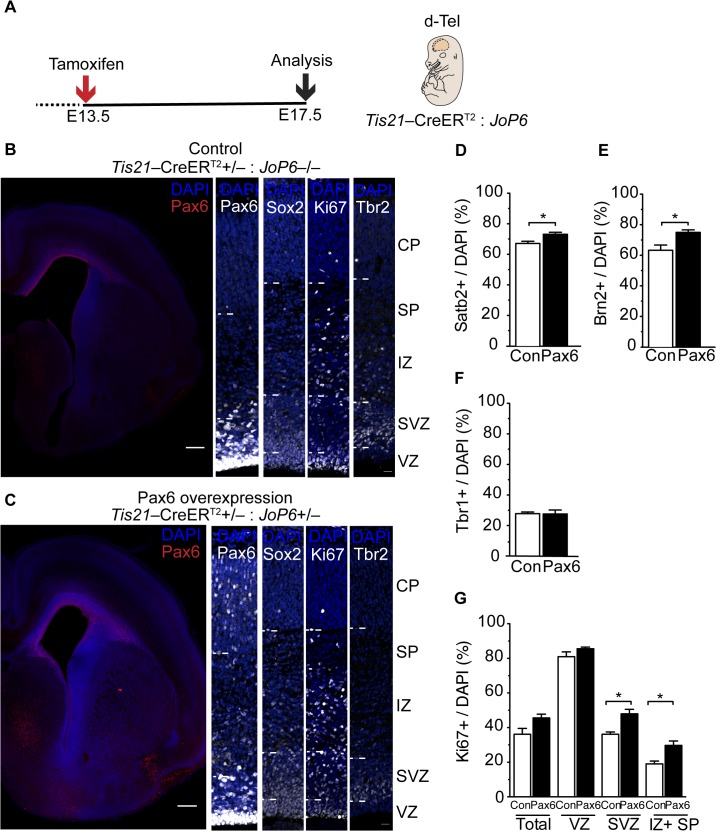
Double-transgenic mouse embryos sustaining Pax6 expression show increased BP abundance and upper-layer neuron production.(A) Flow scheme of experiment. (B–G) Dorsolateral telencephalon of tamoxifen-treated E17.5 Tis21–CreERT2: JoP6 double-transgenic mice; control (Tis21–CreERT2+/–: JoP6–/–) (B) and Pax6 overexpression (Tis21–CreERT2+/–: JoP6+/–) (C) littermates. (B,C) Representative images showing Pax6 (red and white), Sox2 (white), Ki67 (white), or Tbr2 (white) immunofluorescence, combined with DAPI staining (blue), on coronal 50-μm vibratome sections. Scale bars, 20 μm. Note the lack of heterotopia formation in the Pax6 overexpression condition in the Pax6 overview image in (C). (D–F) Quantification of Satb2+ (D), Brn2+ (E) and Tbr1+ (F) nuclei in the cortical plate (100-μm wide area), in control (Con, white) and Pax6 overexpression (black) littermates. (G) Quantification of Ki67+ nuclei in the cortical wall except for the cortical plate (total), VZ, SVZ, and intermediate zone plus subplate (IZ + SP) (100-μm wide area), in control (Con, white) and Pax6 overexpression (black) littermates. (D–G) Mean of three to six embryos from two different litters. Error bars, SEM. * p < 0.05.